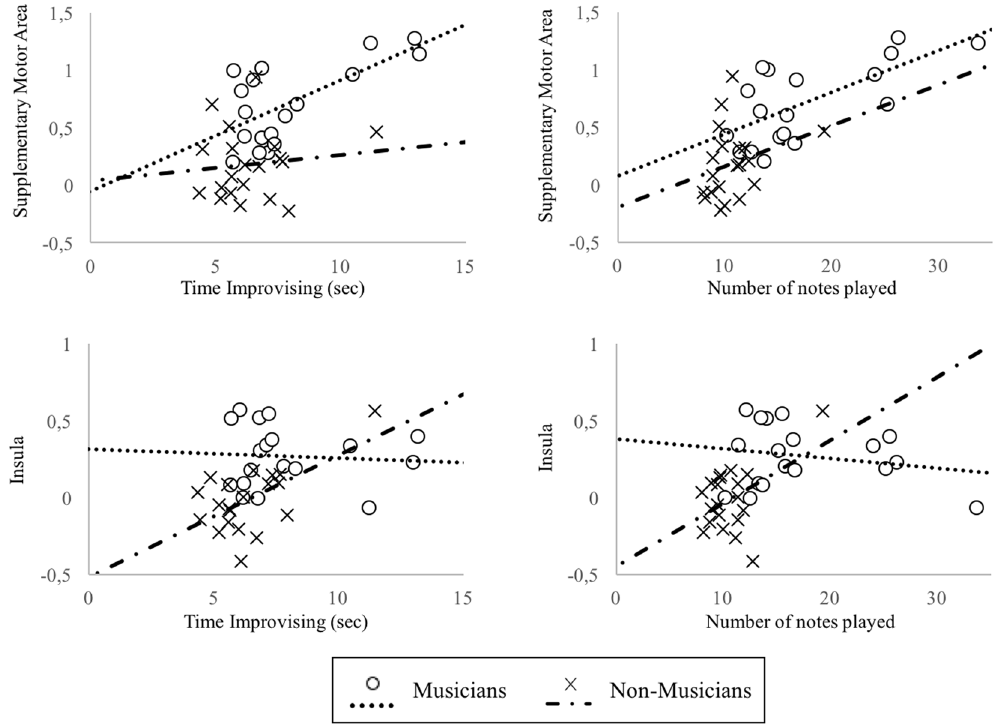
Figure 2. Correlations between SMA and Insula activation and the time and the number of notes played during improvising. Dots and dots line represent musicians, crosses and dash dotted line represent